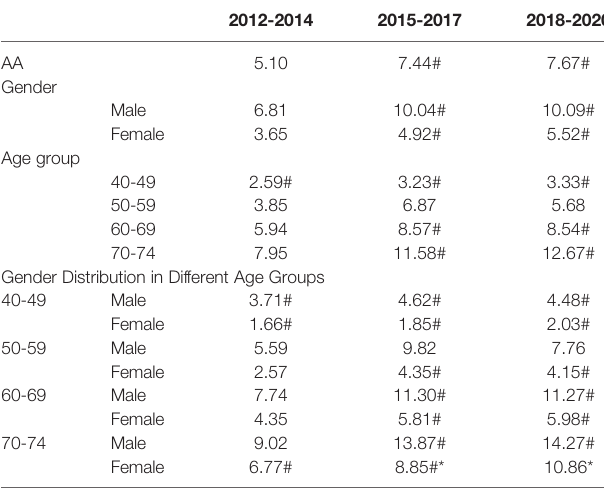
TABLE 12-1 | Analysis of CRC detection rate in 3 cycles of screening, (%). TABLE 12-2 | Analysis of AA detection rate in 3 cycles of screening, (%).